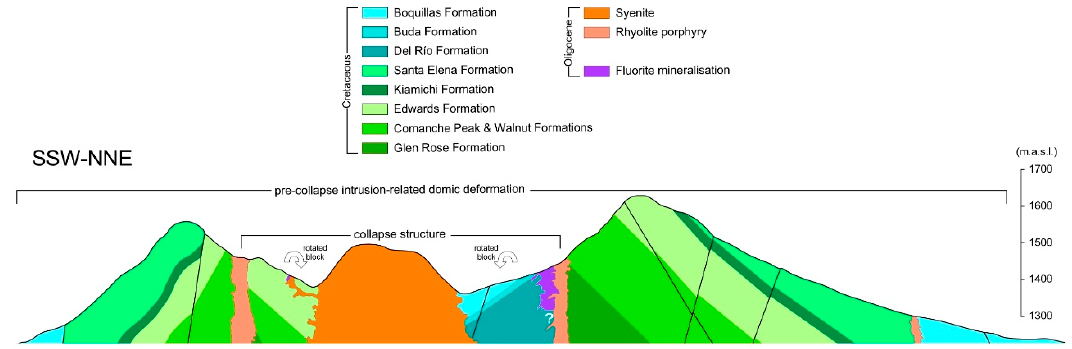
Figure 2. Representative cross-section of the Aguachile deposit, Coahuila. Adapted from [5]. No vertical exaggeration.